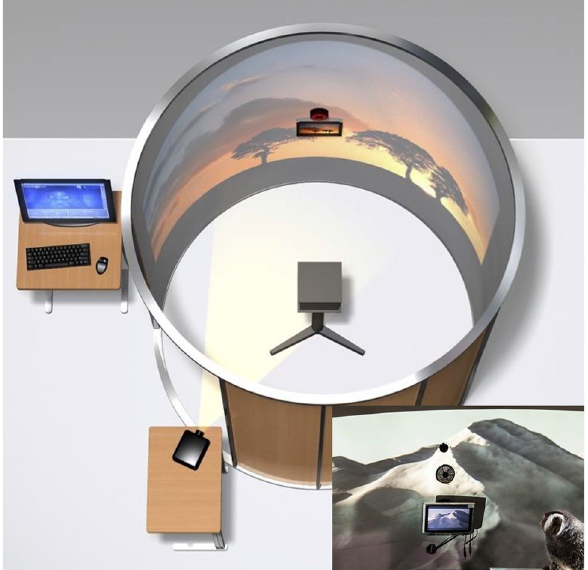
Figure 2. The viewing cylinder the marmosets were in during lens interruption. The inset is a photo of the natural scenes projected on the walls of the viewing cylinder (photographed and rendered by William Bourassa). Marmosets viewed these natural scenes when lens wear was interrupted with unrestricted